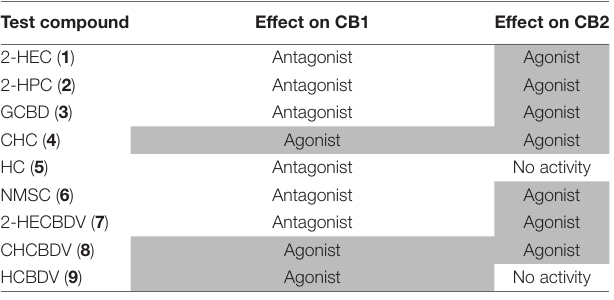
TaBlE 4 | Effect of cannabidiol (CBD)‑ and cannabidivarin (CBDV)‑derivatives on cannabinoid CB1‑and CB2‑receptors (agonistic activity highlighted in gray). Test compound